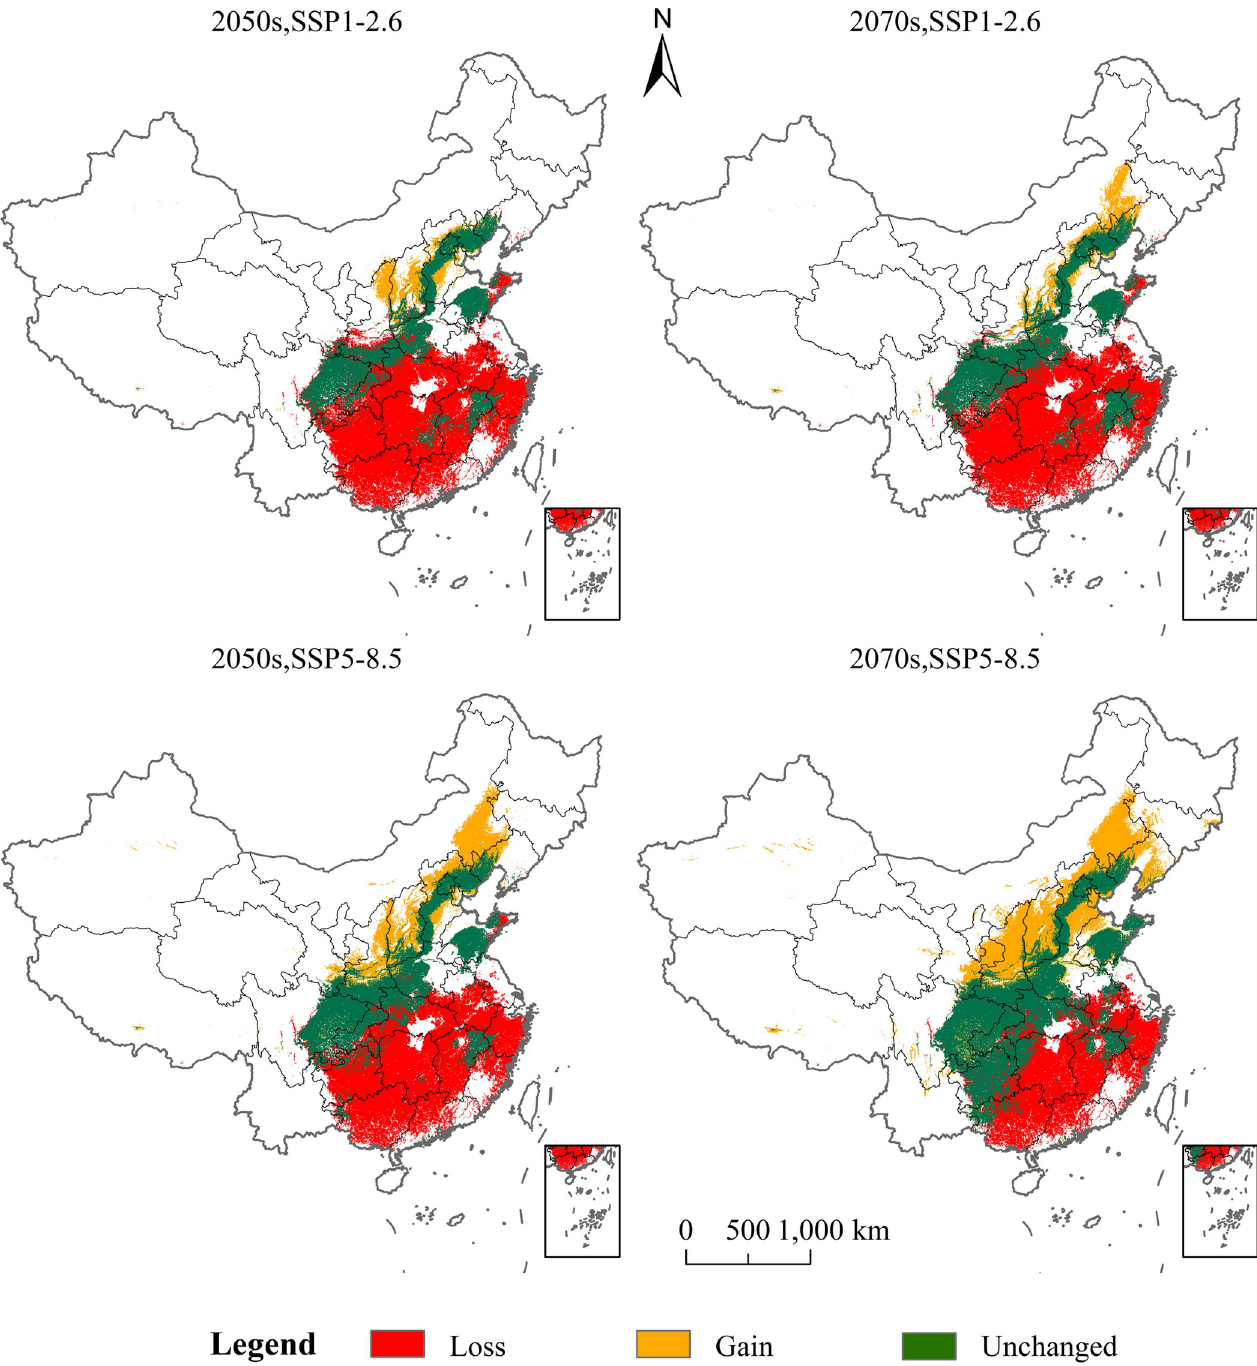
Fig 9. Changes of potential geographical distribution of P . tatarinowii under future climate change scenarios. This map was made in ArcGIS 10.2 using the resulting rasters produced by MaxEnt. The boundary was obtained from the Ministry of Natural Resources of the People’s Republic of China (http://bzdt. ch.mnr.gov.cn/index.html), Map review number: GS(2016)2923.